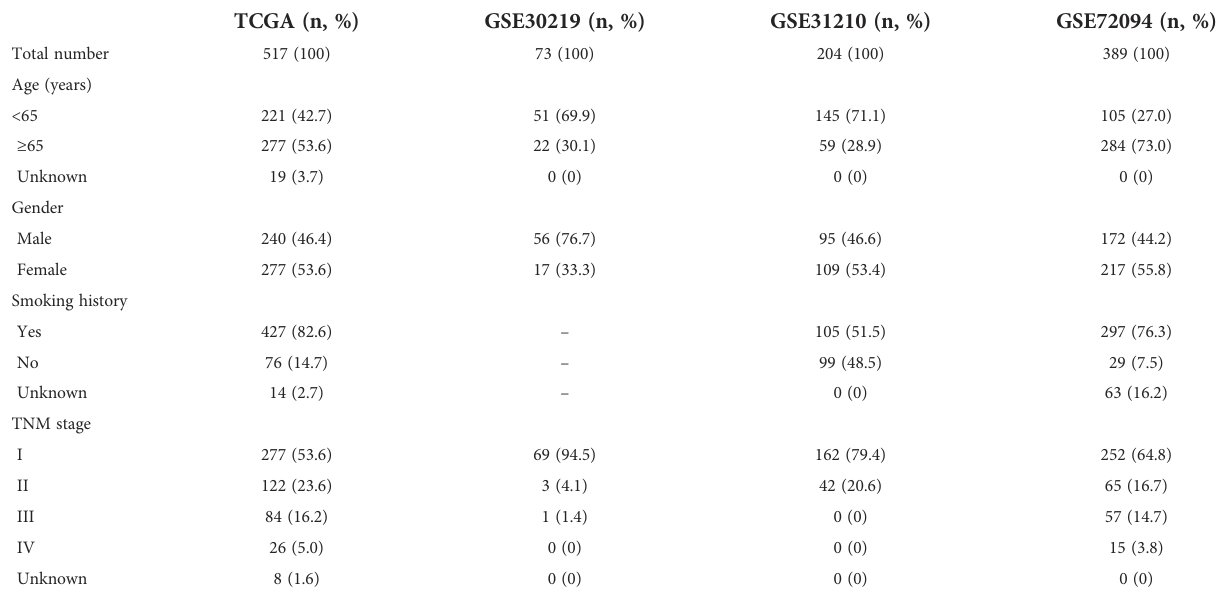
TABLE 1 Clinical characteristics of LUAD patients from TCGA and GEO